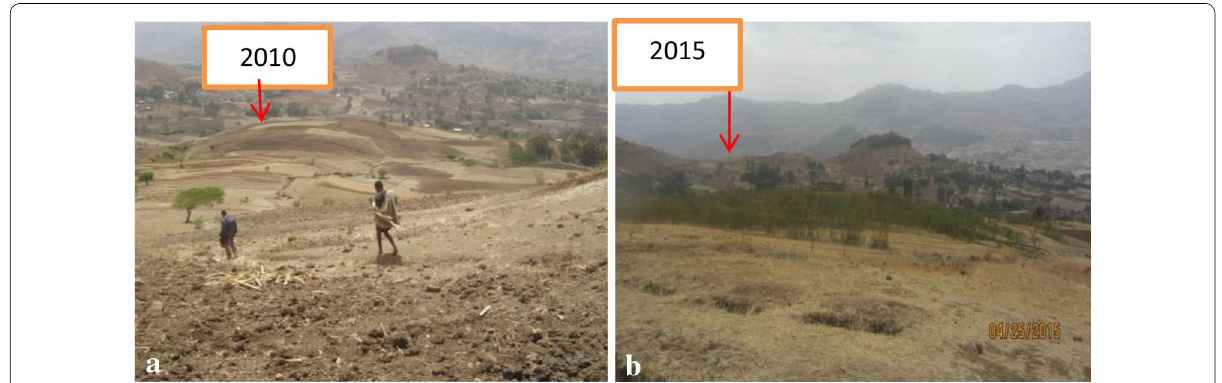
Fig. 3 Vegetation cover on the cropland of the study area in 2010 ( a ) and 2015 ( b